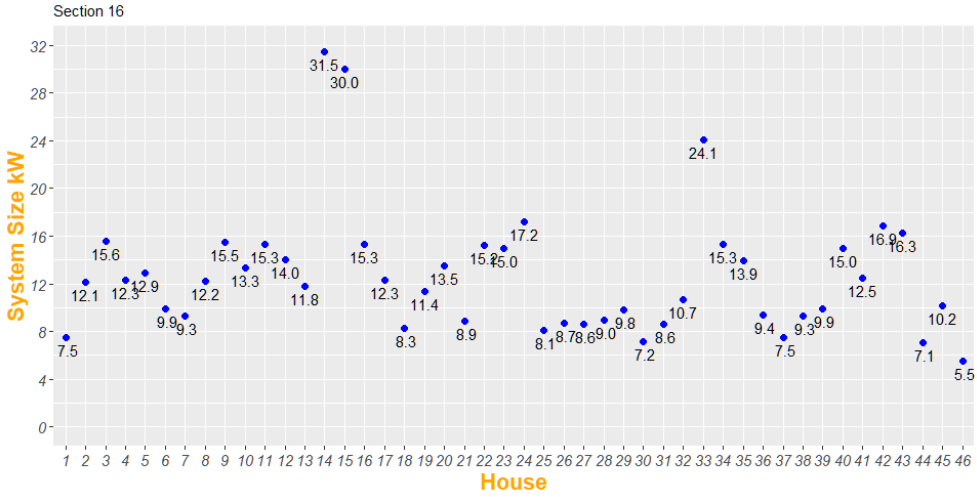
Figure 17. Maximum system size supported per home.